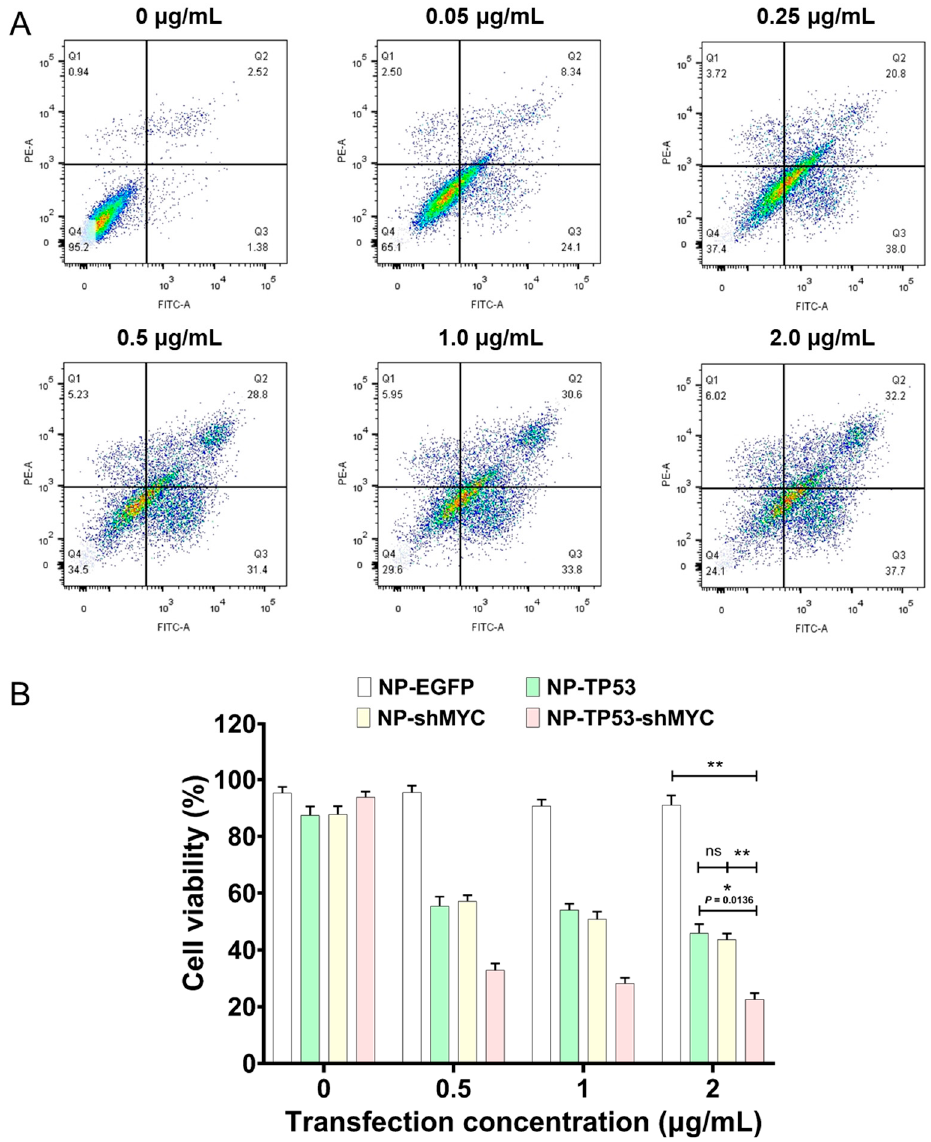
Figure 4. NP-TP53-shMYC enhanced breast cancer cell apoptosis. ( A ) A flow-cytometry-based assay of apoptosis with FITC-labeled Annexin V and PI was performed when MDA-MB-231 cells were transfected with different concentrations of NP-TP53-shMYC (0–2.0 μ g/mL) by 1% Lipofectamine 2000 for 48 h. ( B ) Cell viability assay based on flow cytometry. The asterisk indicates a statistically significant difference of two different groups by two-sided Student’s t -test (ns, not statistically significant, * P < 0.05, ** P < 0.01).